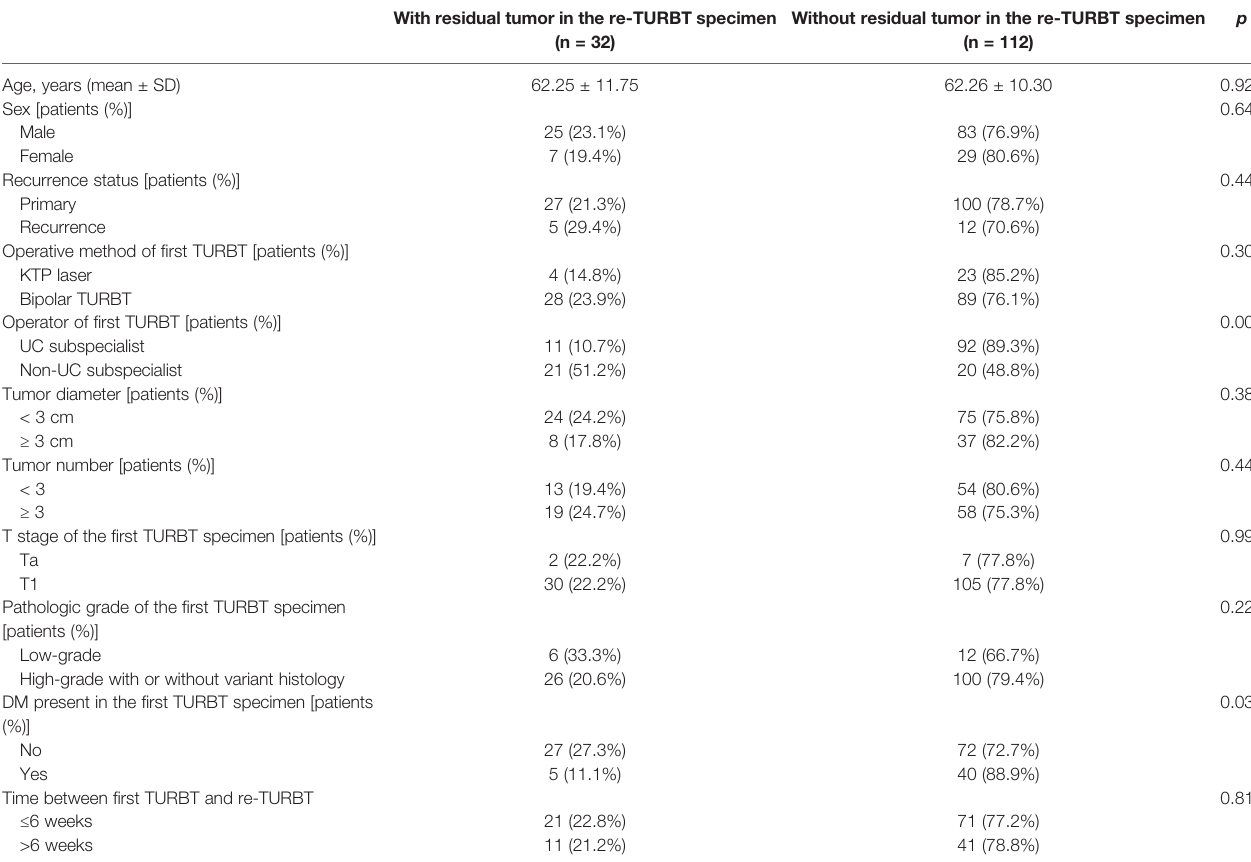
TABLE 2 | Comparison of patients with and without residual tumor in re-TURBT specimens.